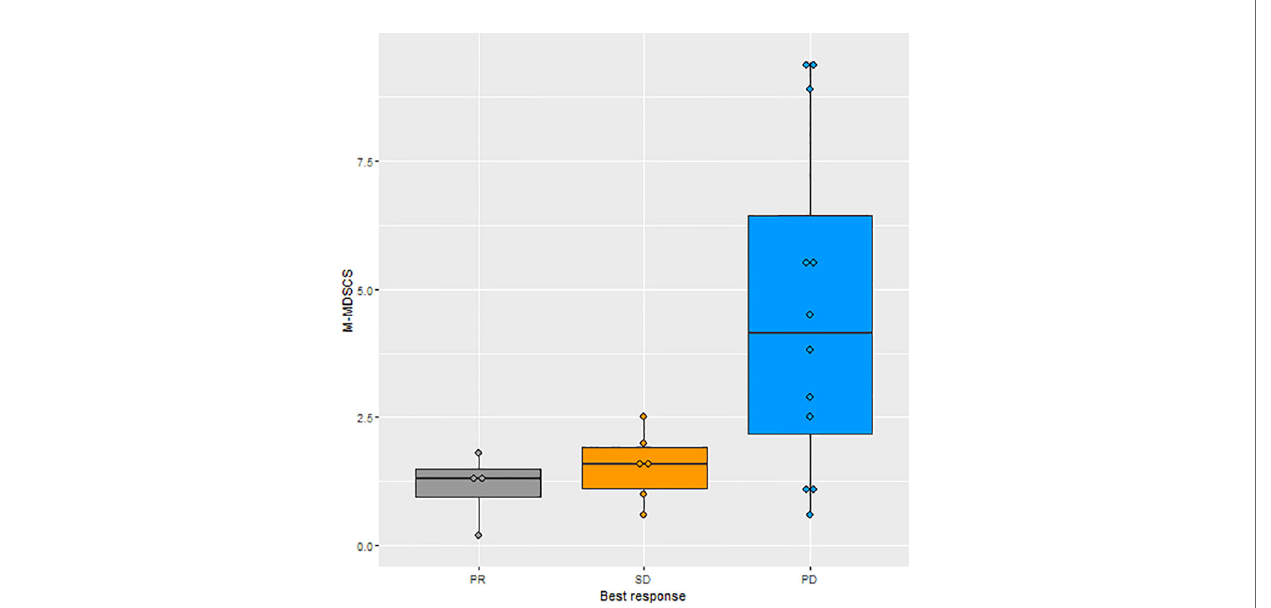
FIGURE 1 | Boxplot of the distributions of M-MDSC levels in relation to best tumor response. M-MDSC, monocytic myeloid-derived suppressive-like